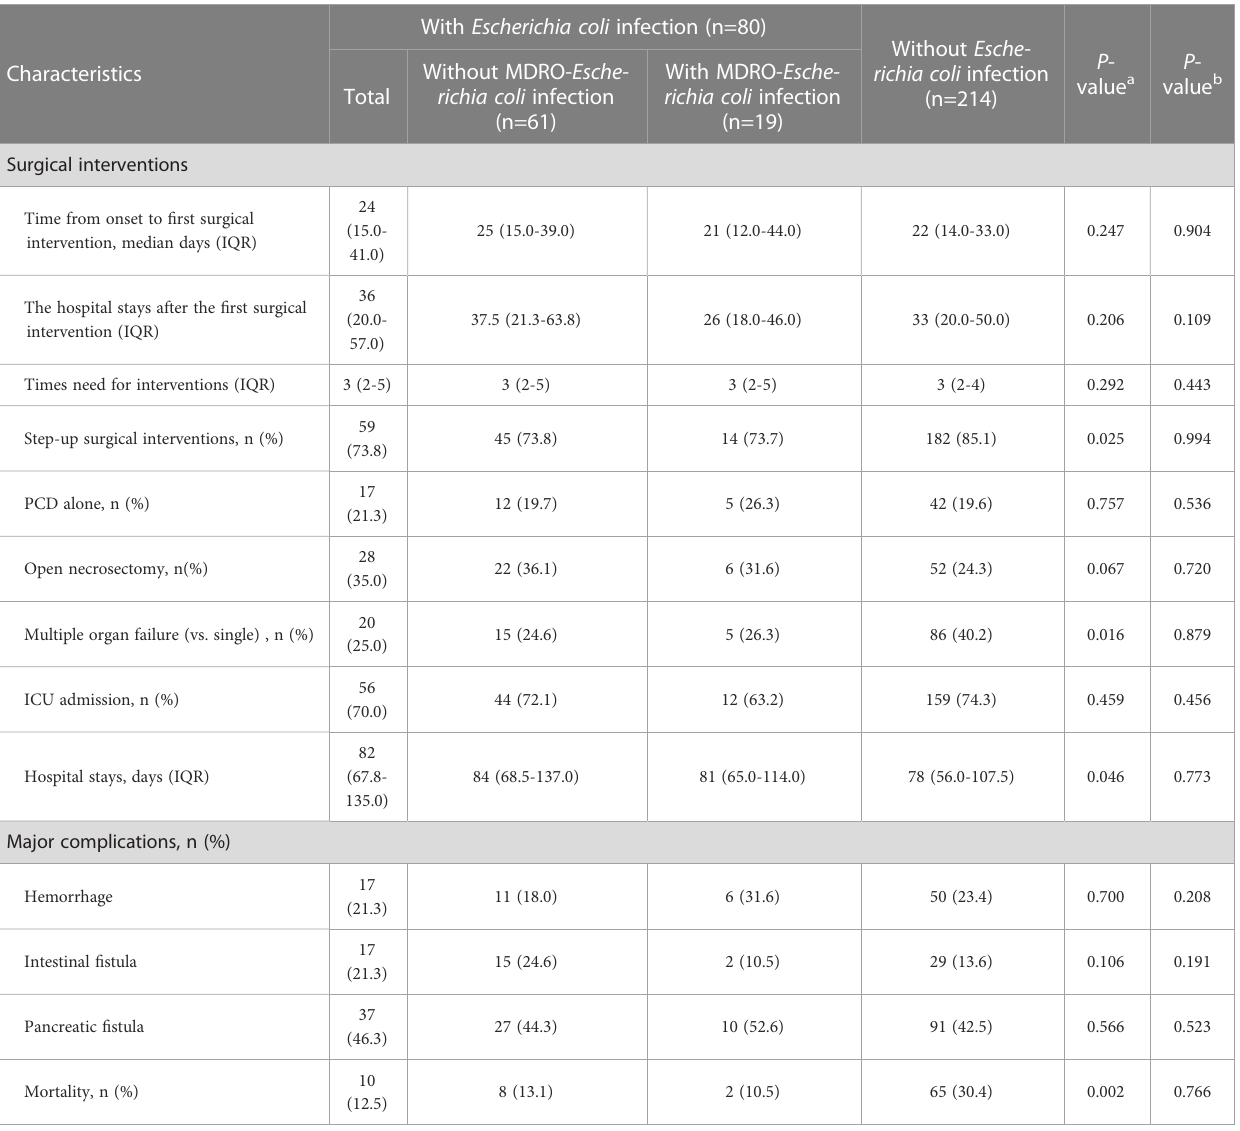
TABLE 2 Comparison of patient outcomes among the four groups.